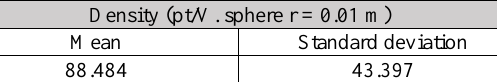
Figure 5. Density analysis (histogram).